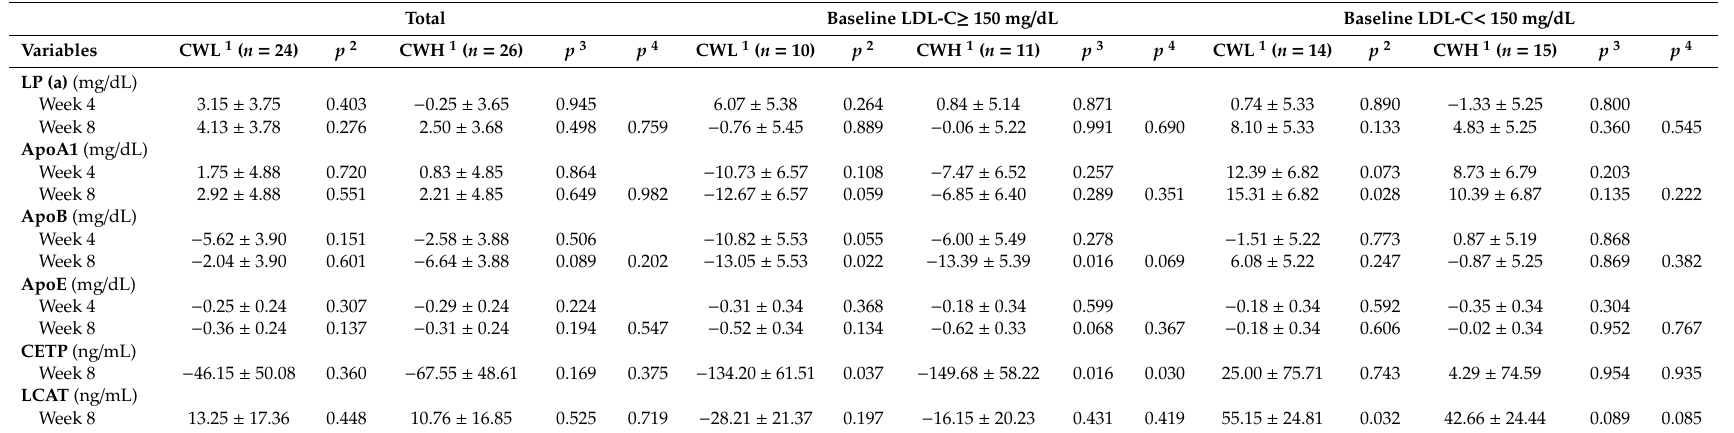
Table 2. Changes in lipid parameters through a linear mixed-e ff ect model used to analyze group, time and group*time e ff ects after 8